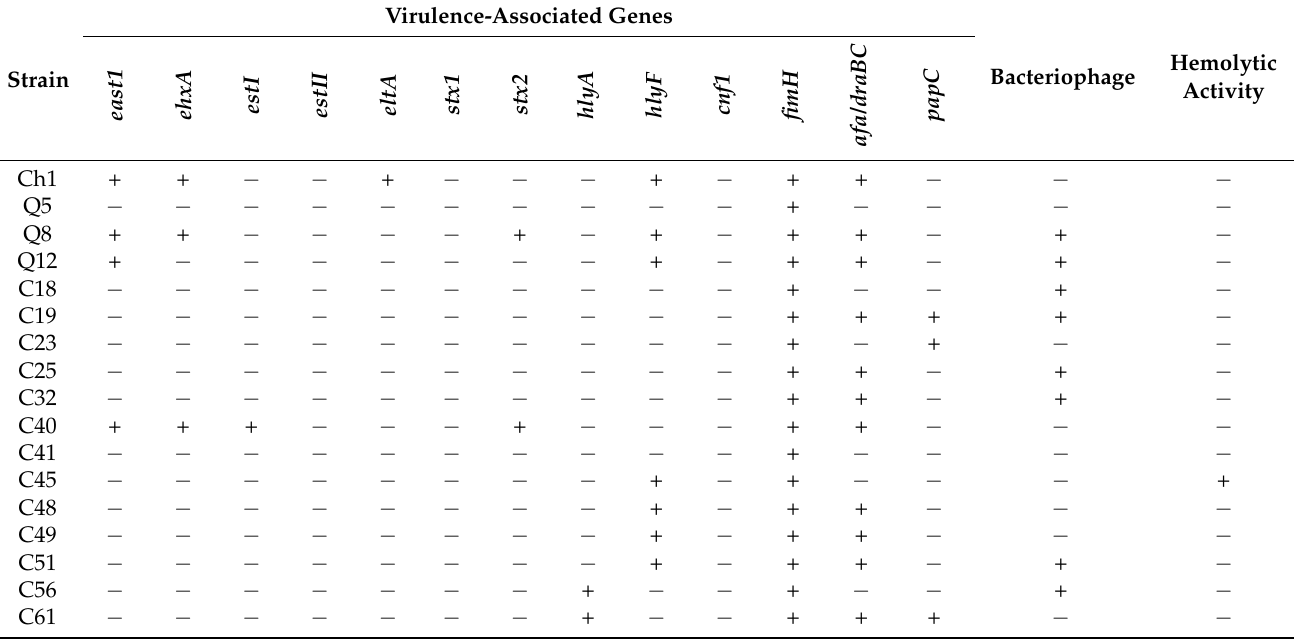
Table 6. Virulence-associated genes, presence of bacteriophages and hemolytic activity of bacteriocin- producing E. coli